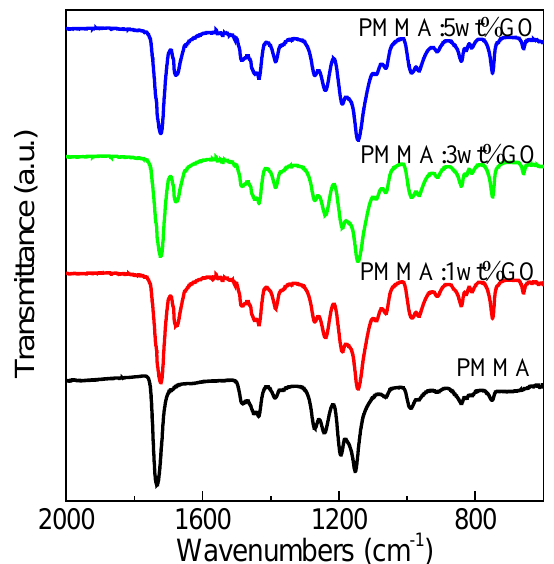
Figure 3. FTIR spectra of PMMA and PMMA:GO composites with the content of GO 1 wt %, 3 wt %, and 5 wt %.